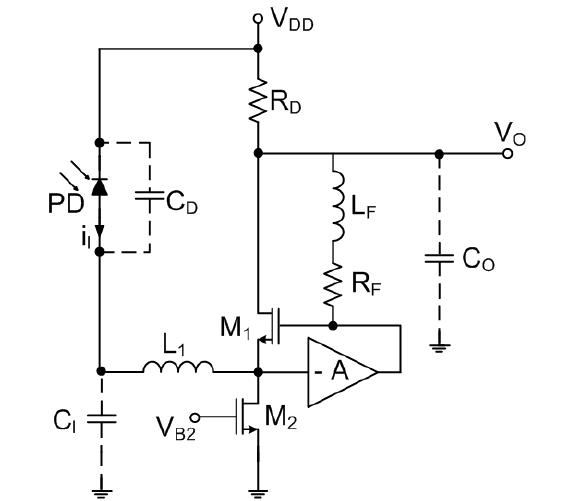
Figure 11. Modified RGC TIA with local inductive feedback (Cherry-Loop